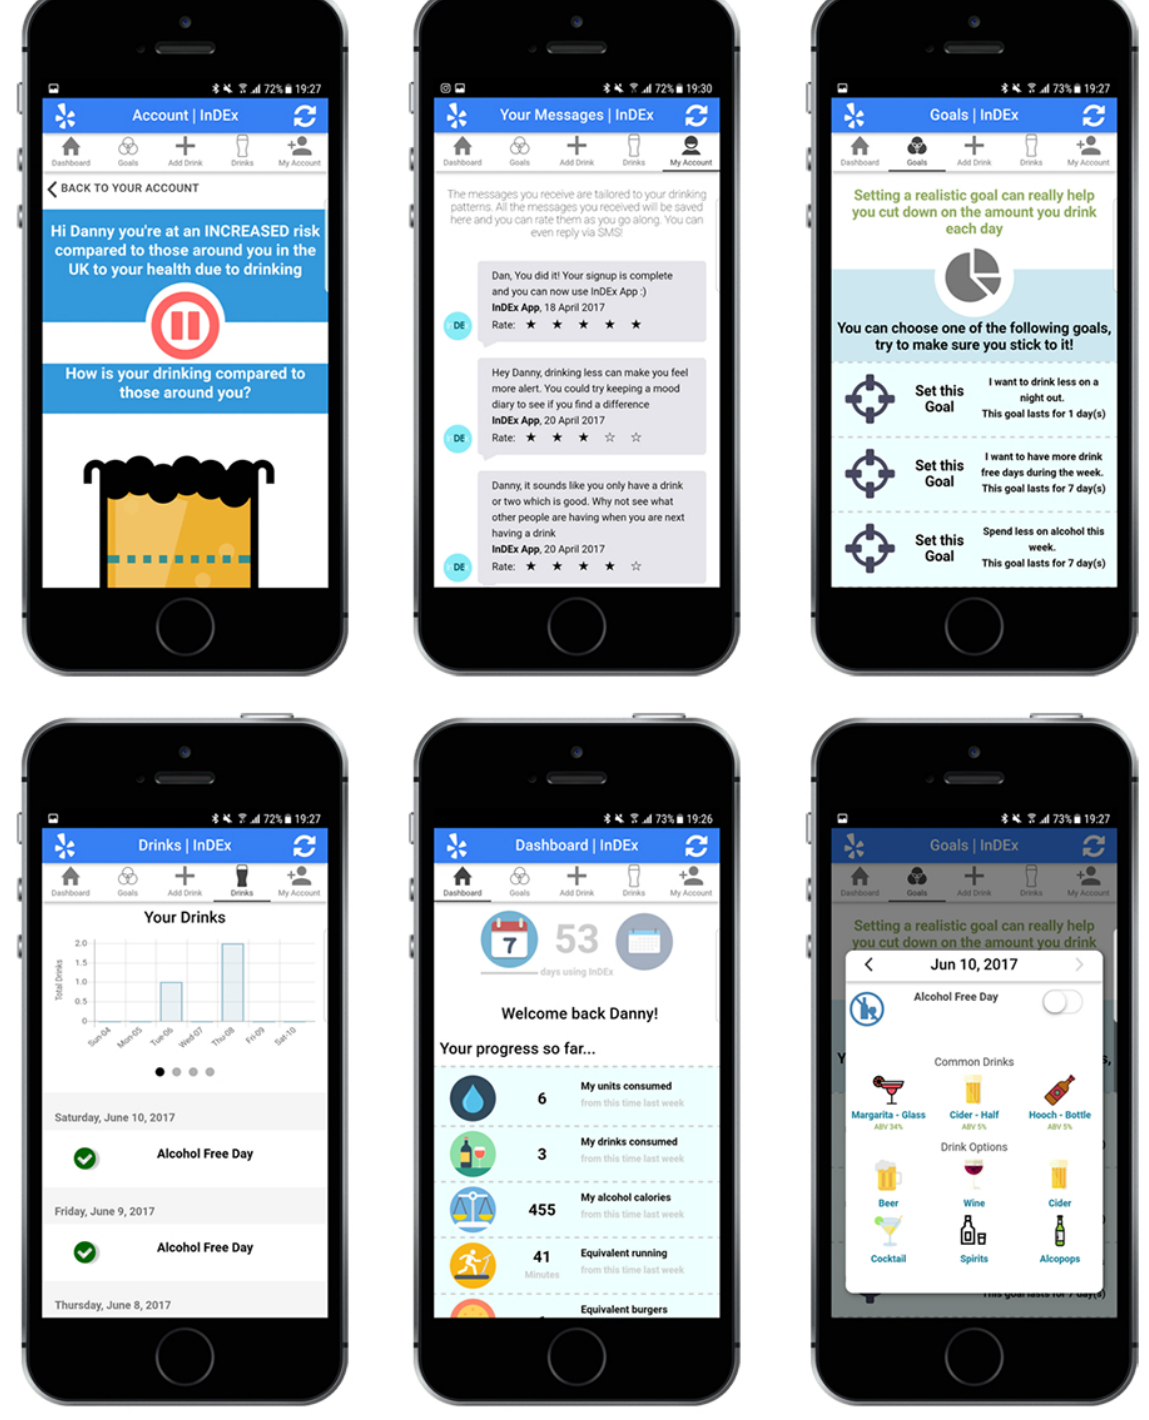
Figure 1. Example screenshots of interactions with the InDEx app (left to right, beginning at top): normative feedback, personalized text